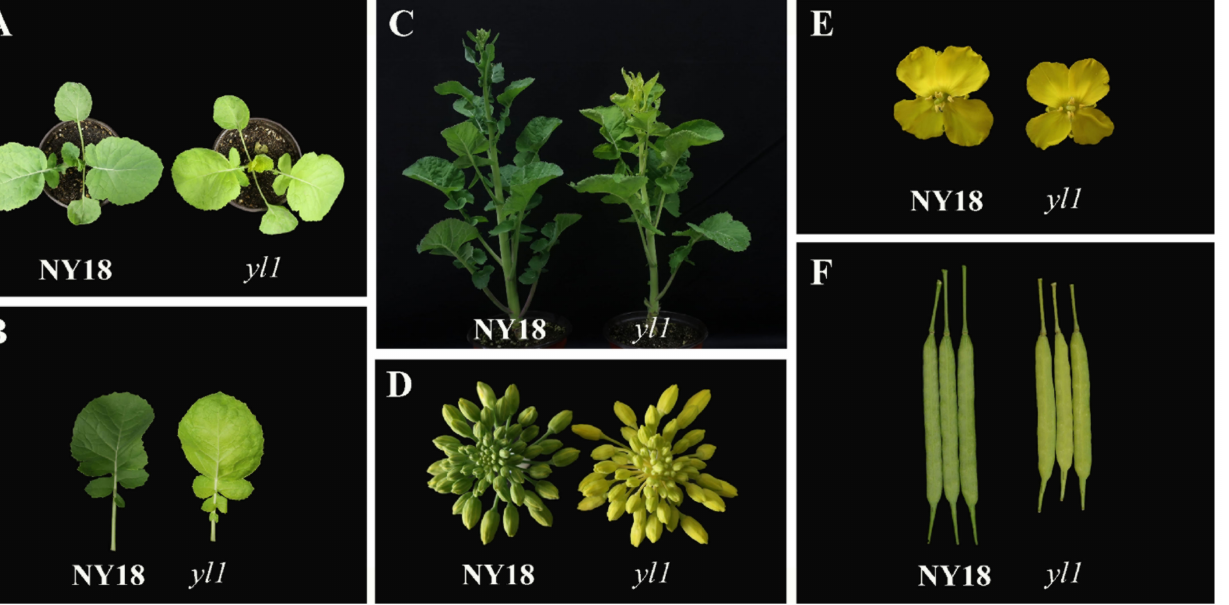
Figure 1. Phenotypic expression of mutant yl1 over the entire growth period. ( A ) The phenotype of NY18 and yl1 in seedling stage; ( B ) leaf color of NY18 and yl1 ; ( C ) the phenotype in budding stage; ( D ) the color of flower buds in NY18 and yl1 ; ( E ) the size of petals; ( F ) the color and size of